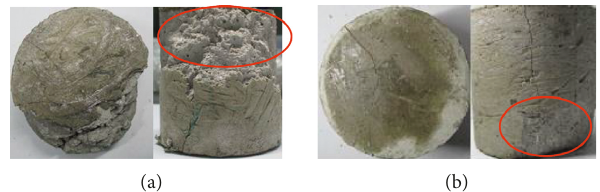
Figure 7: Typical failure modes of foam concrete under impact loading. (a) S-4-5. (b)